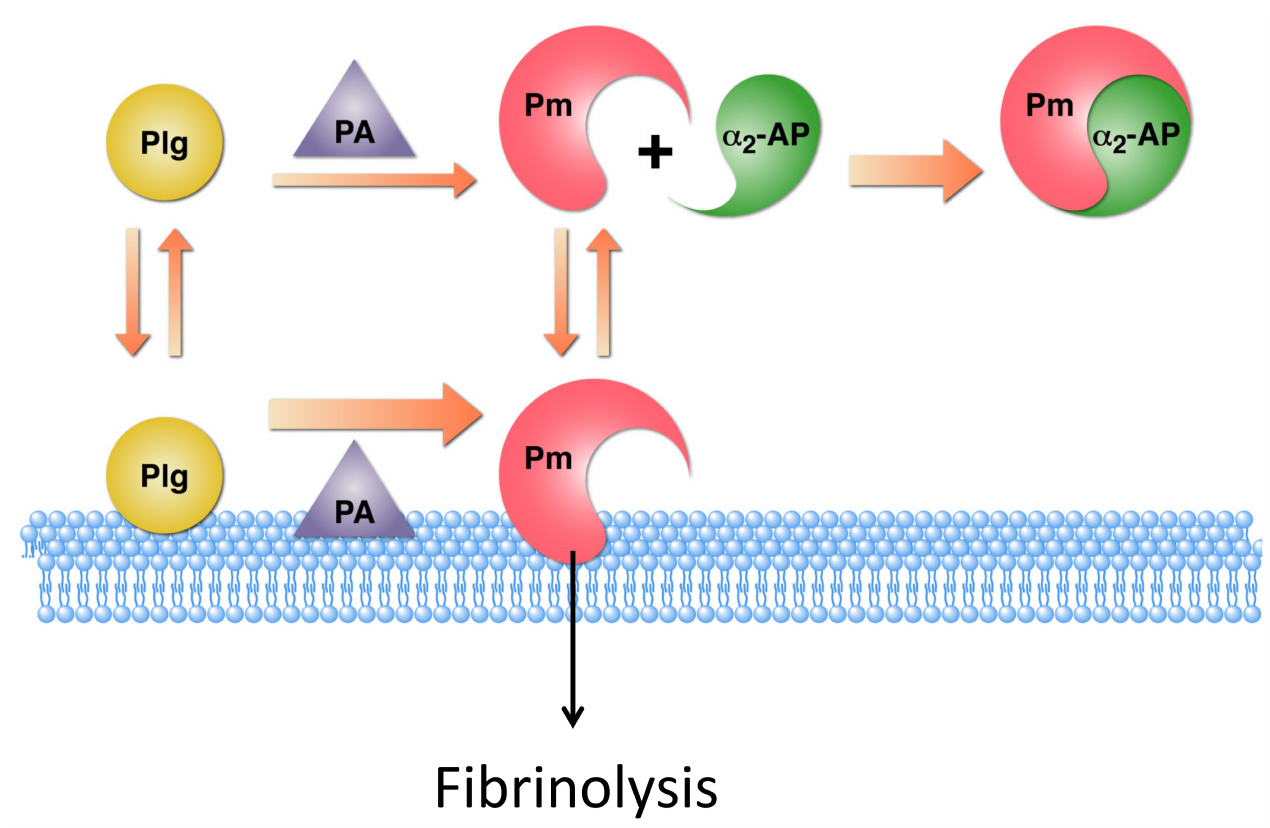
Figure 1. Enhancement of plasminogen activation on the cell surface. Activation of cell-associated plasminogen (Plg) to plasmin (Pm) by cell-associated plasminogen activators (PA) is markedly enhanced compared to the reaction in solution. The Pm formed remains on the cell surface, where it is relatively protected from its inhibitor, α 2 -antiplasmin ( α 2 -AP). This results in the association of the proteolytic activity of plasmin with the cell surface to function in fibrinolysis. This figure is modified from a figure originally published in © 2012 Miles, L.A.; Andronicos, N.M.; Chen, E.I.; Baik, N.; Bai, H.; Parmer, C.M.; Lighvani, S.; Nangia, S.; Kiosses, W.B.; Kamps, M.P.; Yates, J.R., III; Parmer, R.J. Published in under CC